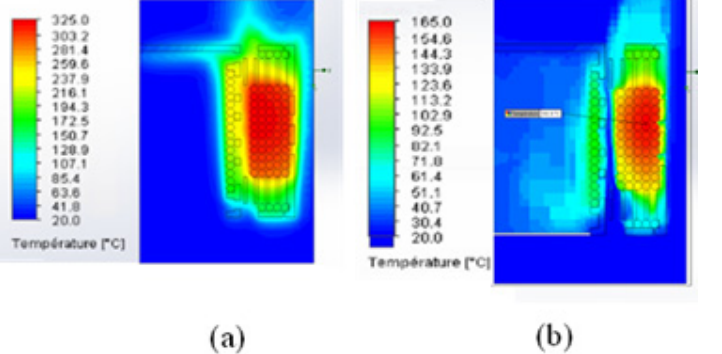
Figure 14. Thermal simulation of the air-core transformer: ( a ) Conductor focus; ( b ) Support focus.